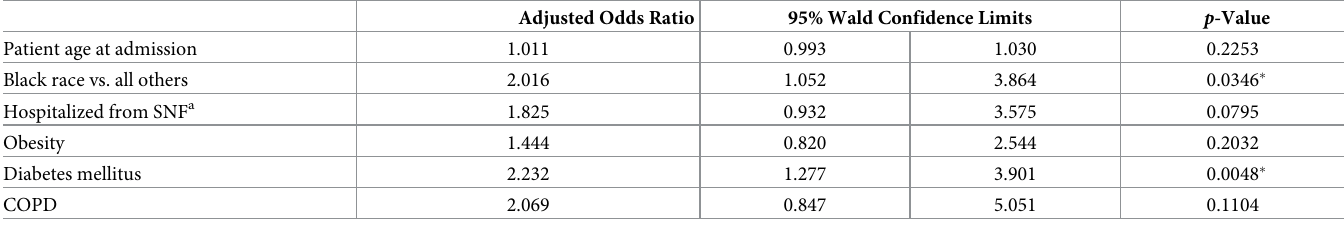
Table 3. Factors associated with severe disease.